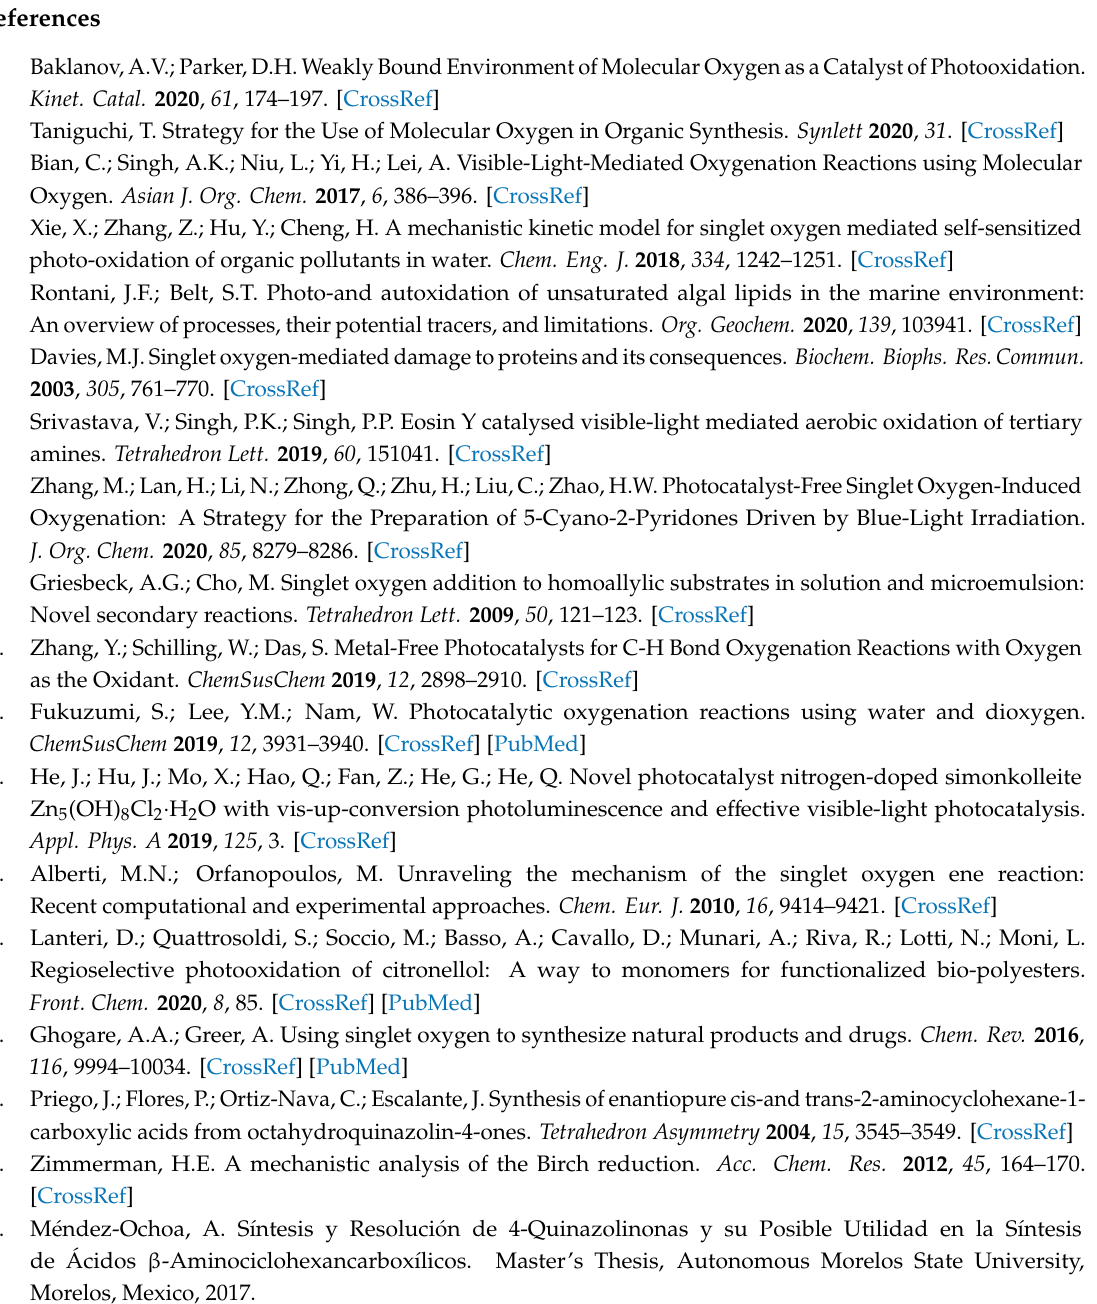
Table S18: Bond Angles for redn (1-acetyl-2-( tert -butyl)-3-methyl-2,3,5,6,7,8-hexahydroquinazolin-4(1H)-one ( 13 ), Table S19: Hydrogen Atom Coordinates (Å × 104) and Isotropic Displacement Parameters (Å2 × 103) for redn (1-acetyl-2-( tert -butyl)-3-methyl-2,3,5,6,7,8-hexahydroquinazolin-4(1H)-one ( 13